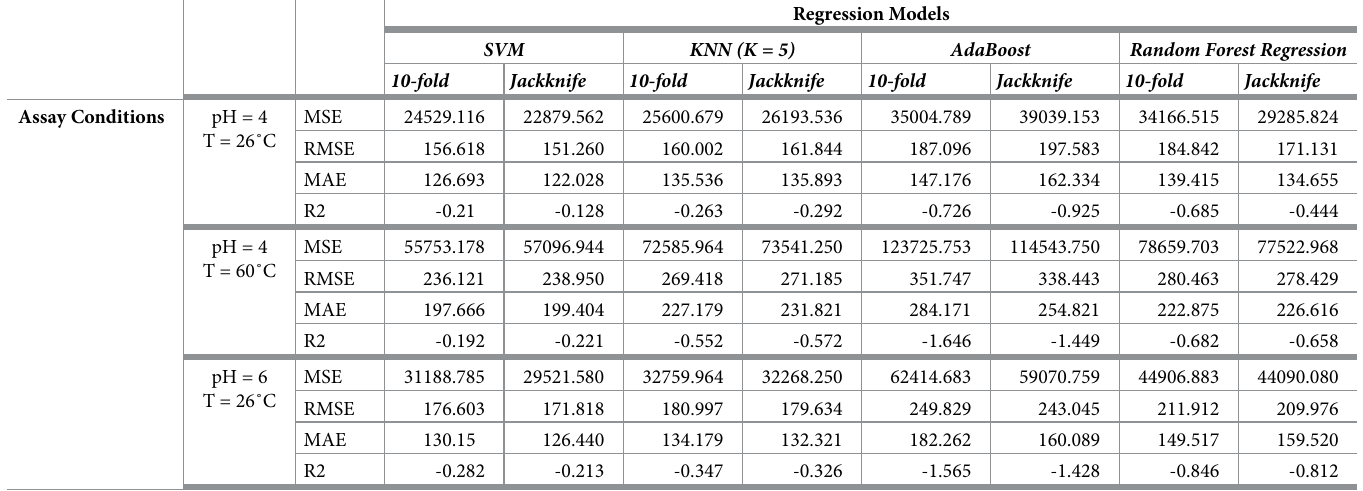
Table 3. Performance measures resulted from four different regression models. The models were validated by stratified 10-fold cross validation and jackknife methods. The results are related to three different pH/Temperature conditions. (a) pH = 4,T = 26˚C (b) pH = 4,T = 60˚C (c) pH = 6,T =